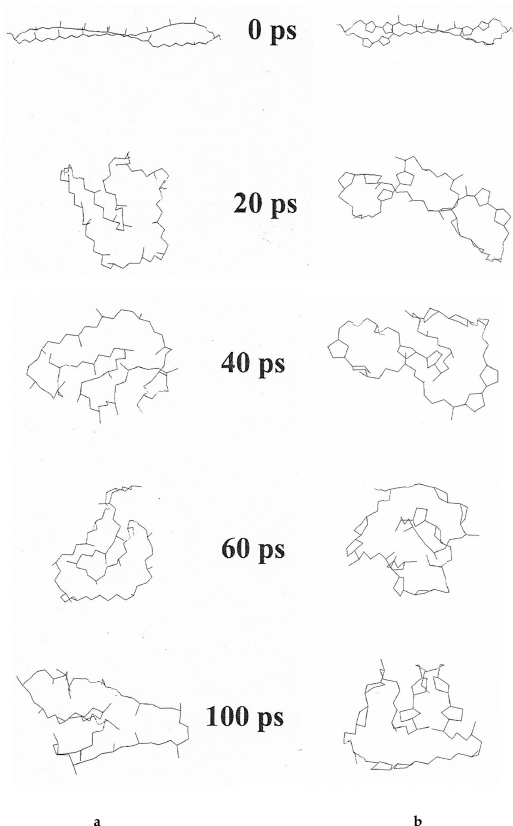
Figure 4. Computer simulation of the dynamics of a single MPL molecule in vacuo. Computer simulation of the dynamics of a single MPL molecule in vacuo without any further restriction was set at 37 °C and a time course of 100 psec (ps). (a) MPL without pentacycles; (b) molecule with a total of eight pentacycles [22].